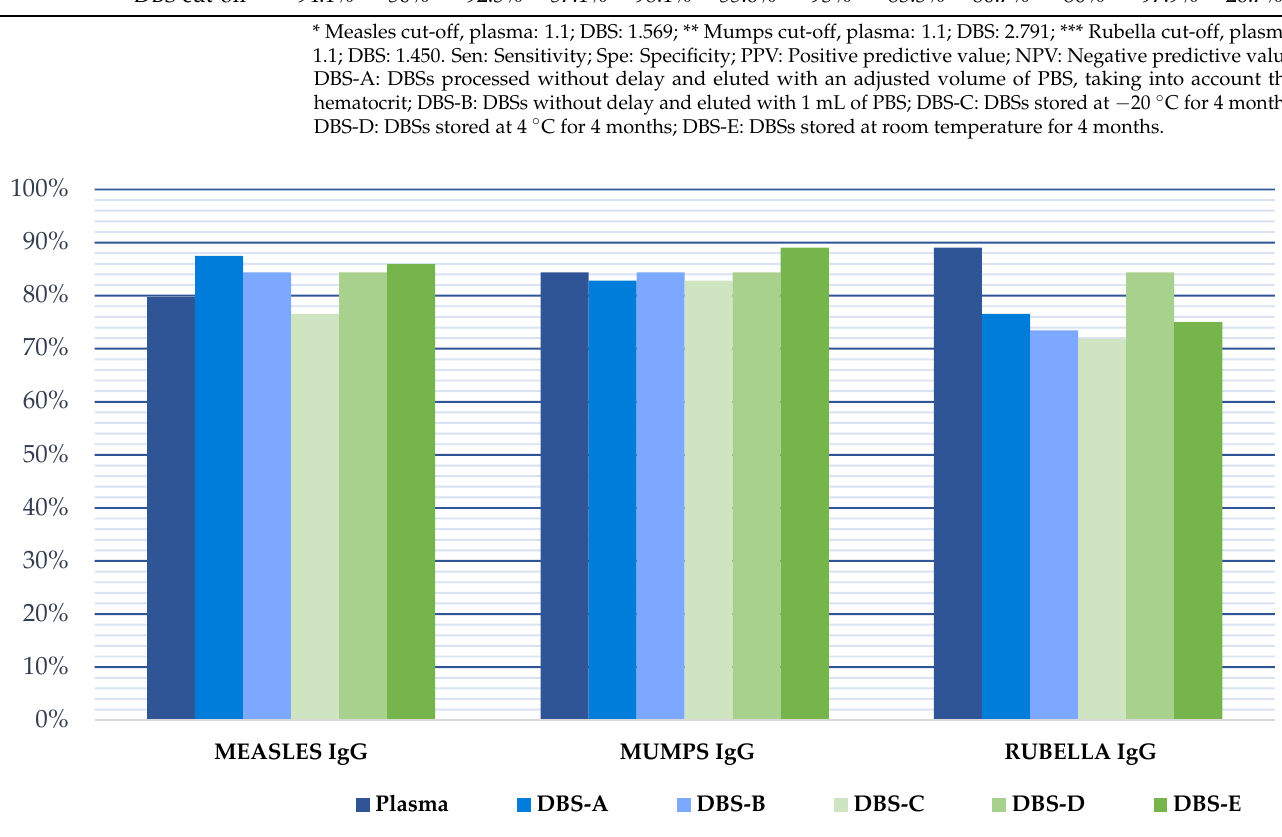
Table 3. Results of VirClia ® -IgG test for the detection of protective IgG against measles, mumps and rubella.